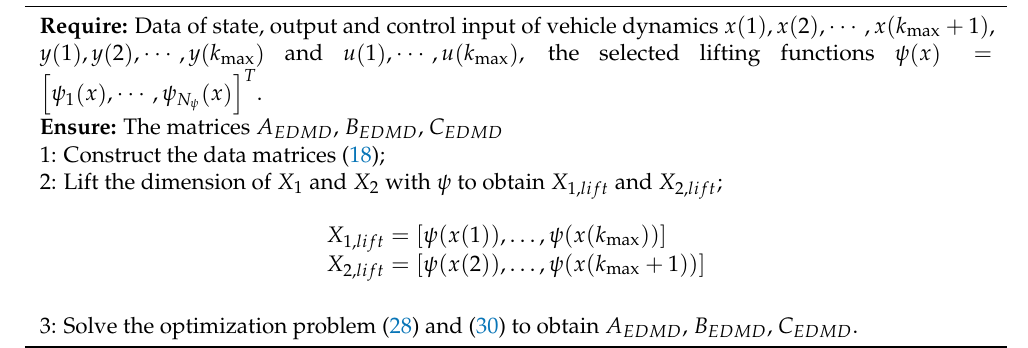
Algorithm 4 Approximation of Koopman operator with the EDMD